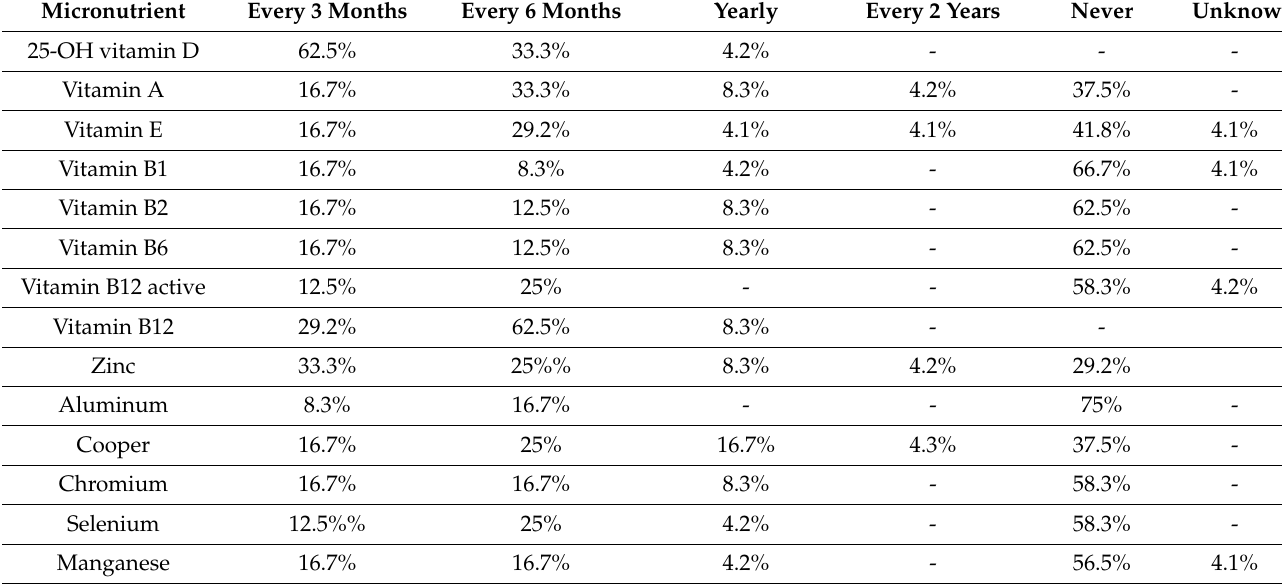
Table 4. Frequency of micronutrient monitoring in Latin America teams.